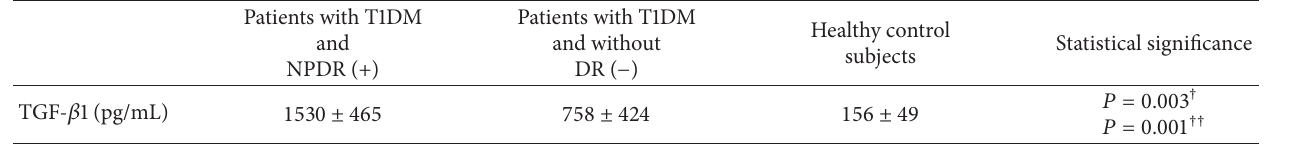
Table 2: Serum TGF- 𝛽 1 levels in T1DM patients and healthy